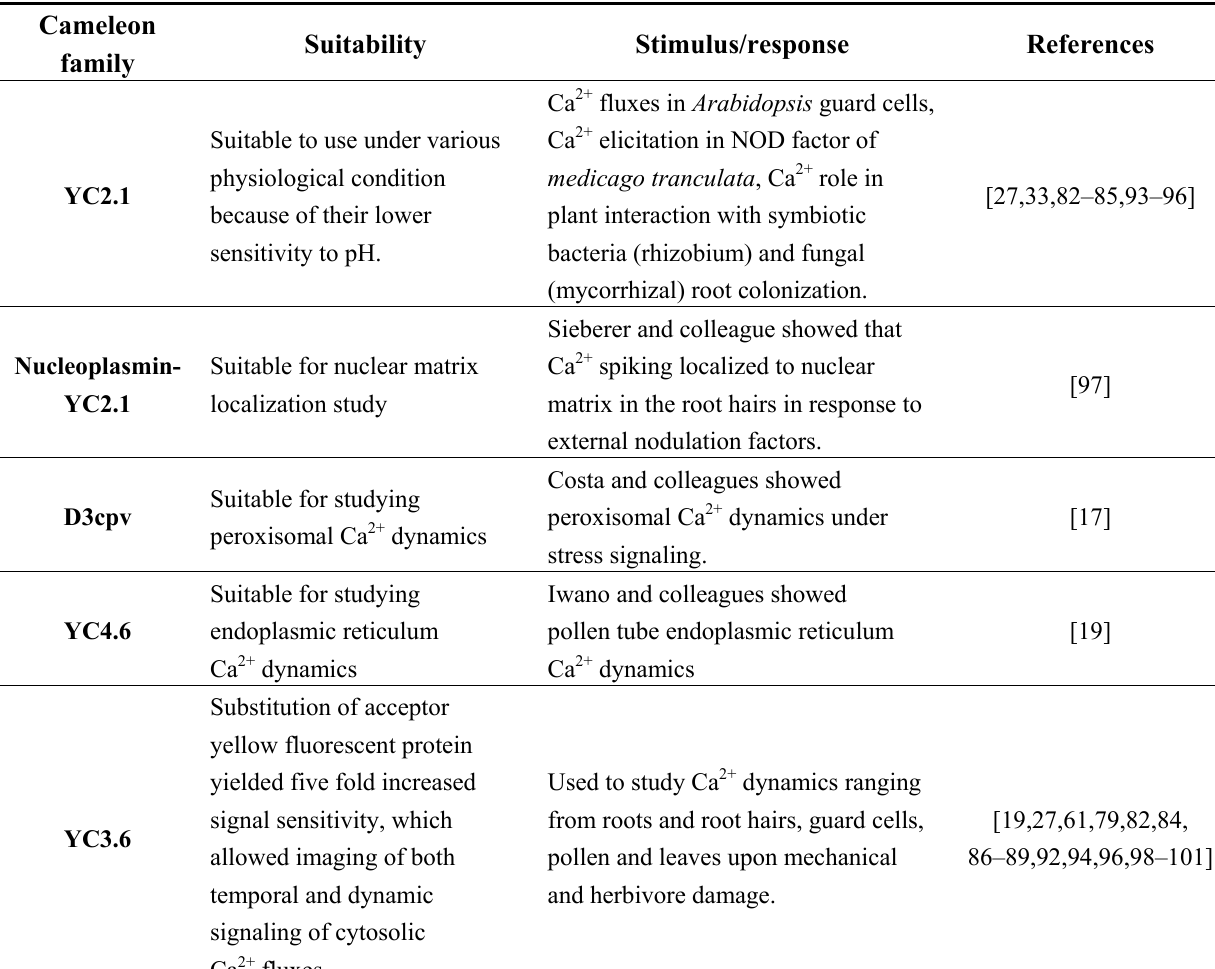
Table 2 lists some of the most used GFP-based Ca 2+ indicators in plant sciences. Table 2. Main GFP-based Ca 2+ indicators used in plant